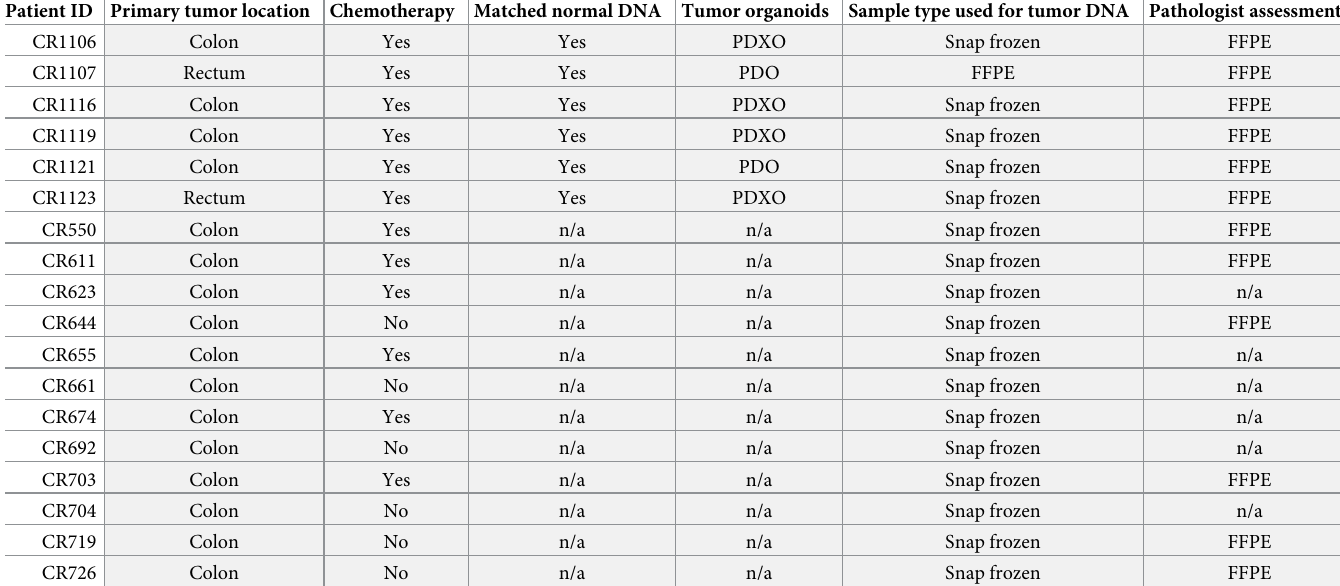
Table 1. Overview of patient colorectal adenocarcinoma liver metastasis